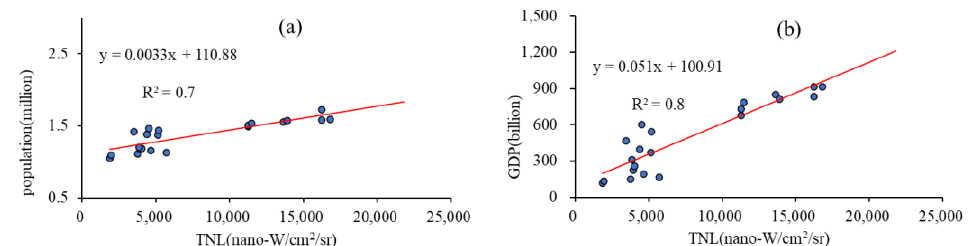
Figure 2. Validation of TNL (total night-time light) with population and GDP correlations. ( a ) TNL- population correlation. ( b ) TNL-GDP correlation.